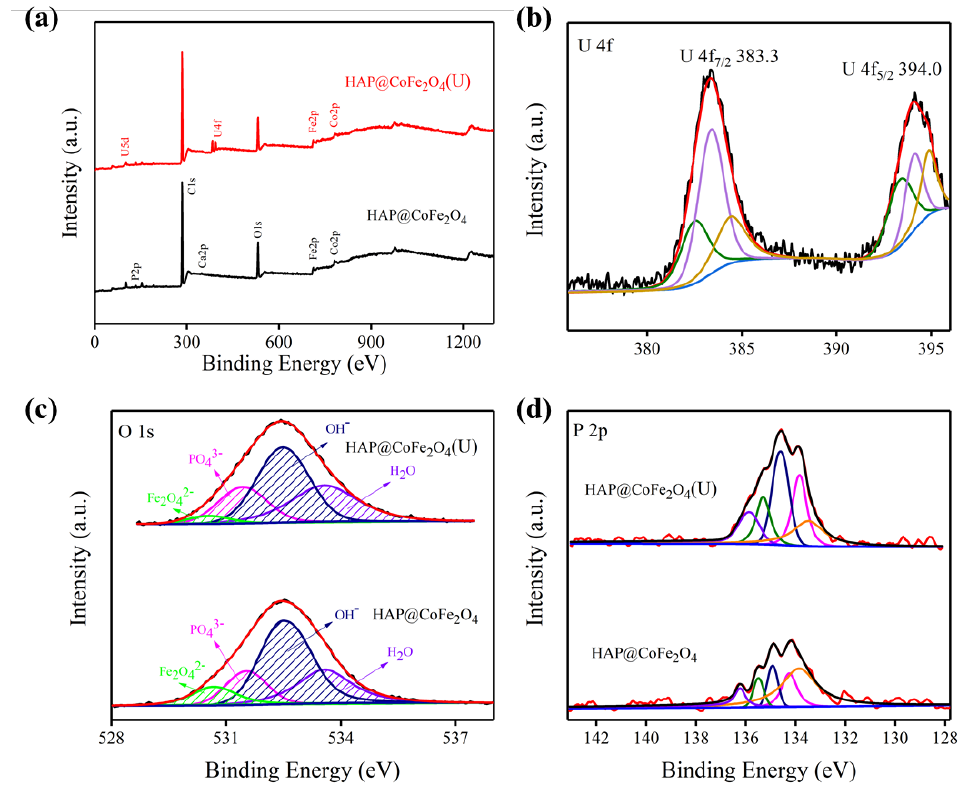
Figure 5. X-ray spectroscopy (XPS) full-survey spectra ( a ) as well as the ( b ) U 4f, ( c ) O 1s, ( d ) P 2p.